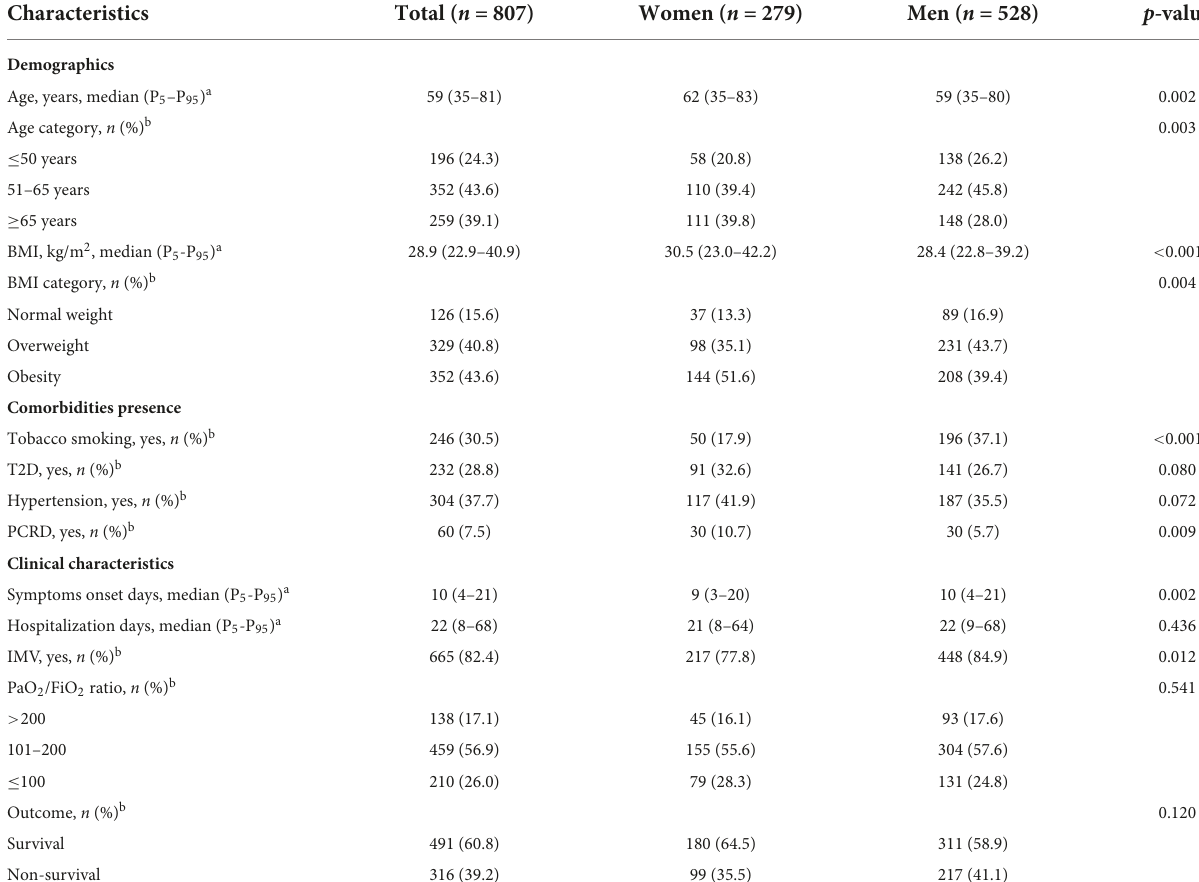
TABLE 1 Demographic and clinical characteristics in patients with